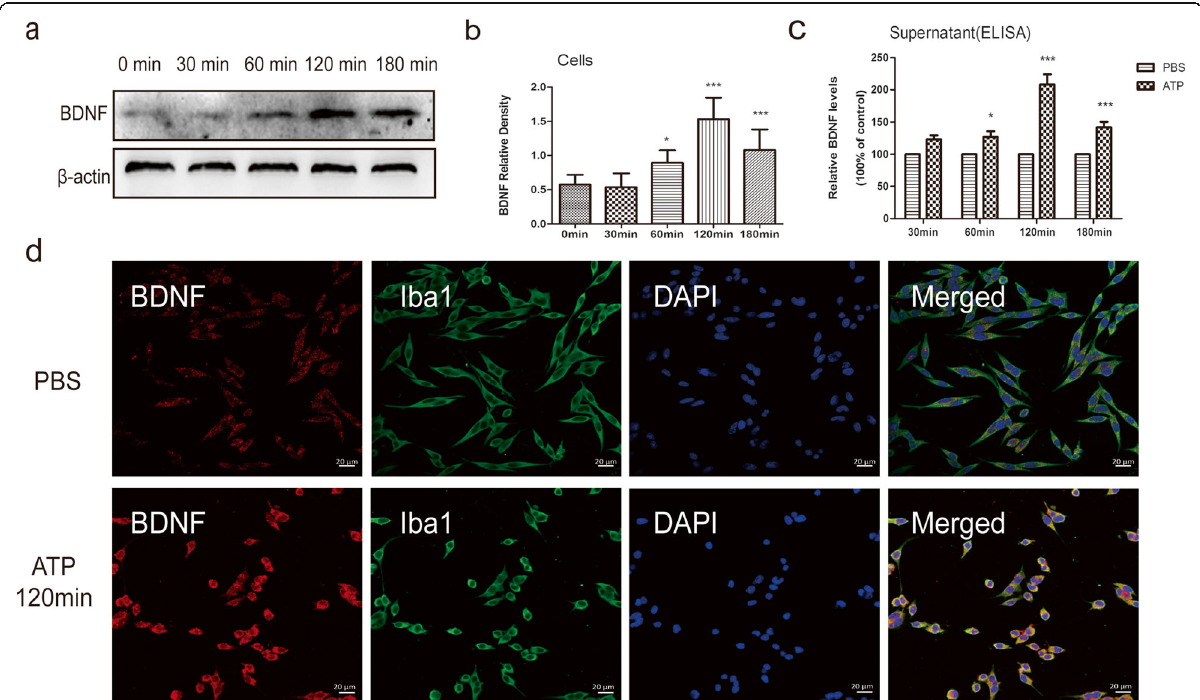
Fig. 5 ATP enhanced BDNF synthesis and release in BV2 microglia cells. BV2 cells were treated with 50 μ M ATP to activate P2X4Rs. At different time points, supernatants and cell lysates were collected. a Representative Western blot results of intracellular BDNF in BV2 cells. b The histogram presents the quantitative analysis of BDNF protein. n = 6/group, one-way ANOVA and Tukey ’ s multiple comparison test. * p < 0.05, *** p < 0.001 versus PBS. c Concentration of BDNF in the supernatants incubated with ATP at different time points. n = 8/group, T test. * p < 0.05, *** p < 0.001 versus PBS. d Immunofluorescence staining for BDNF (red) and Iba1 (green) at 120 min after PBS or ATP stimulation. Scale bar = 20 μ